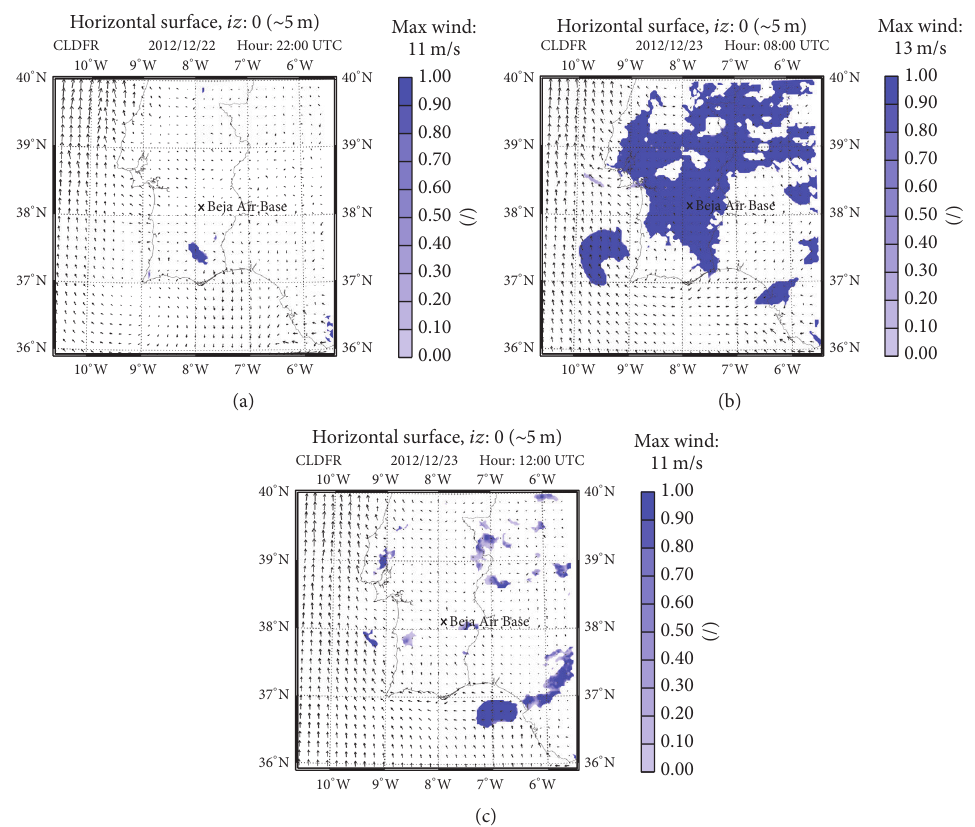
Figure 9: Simulation of cloud fraction (fog, blue scale) and flow (vectors) at 5 m height from the surface, at 22:00, 08:00, and 12:00 UTC in D1